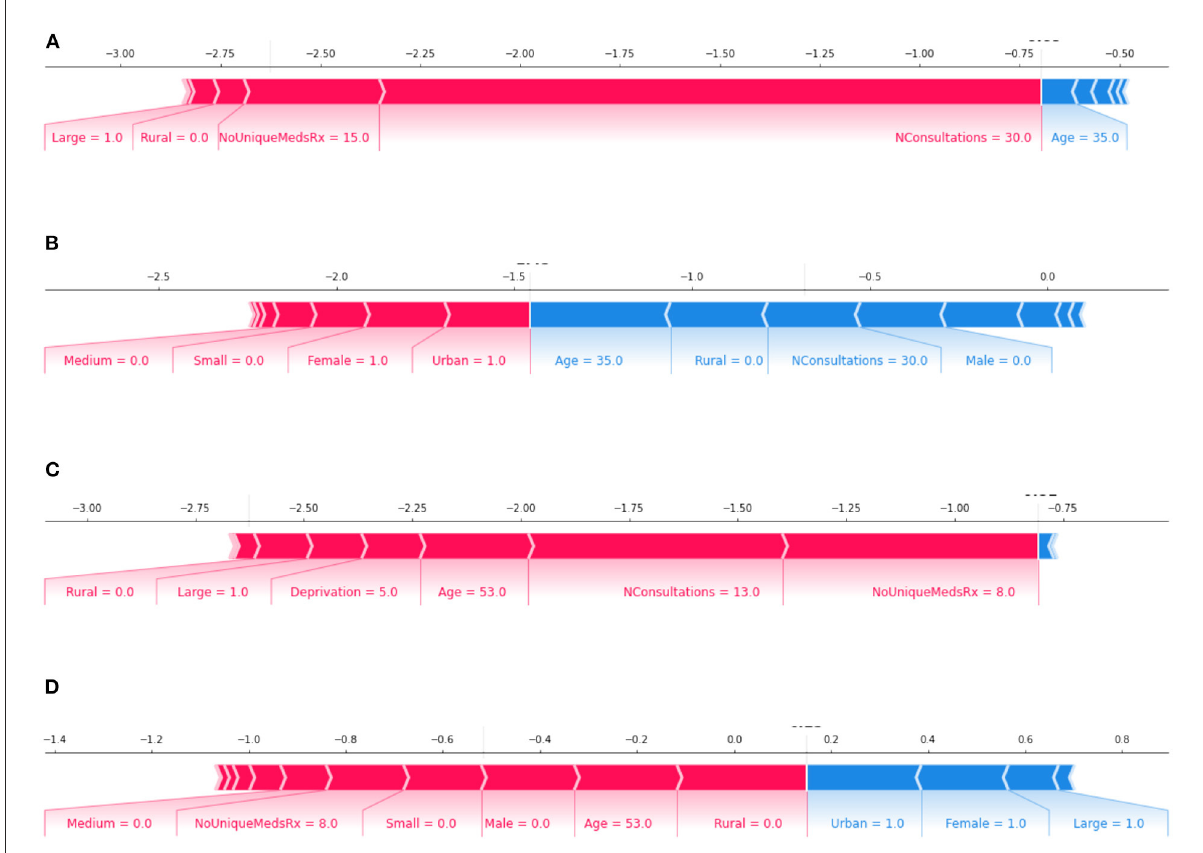
FIGURE7 RED features: increase the prediction of true label; BLUE features: decrease the prediction of true label of the model. Plots (A, B) : Output of a 35-year-old M¯aori female patient; where plot (A) XGBoost correctly classifying as “no Harm” and plot (B) logistic regression wrongly classifying as “Harm.” Plots (C, D) : Output of a 53-year-old NZ European female patient; where plot (C) XGBoost wrongly classified as “no Harm” and plot (D) logistic regression correctly classified as “Harm.”